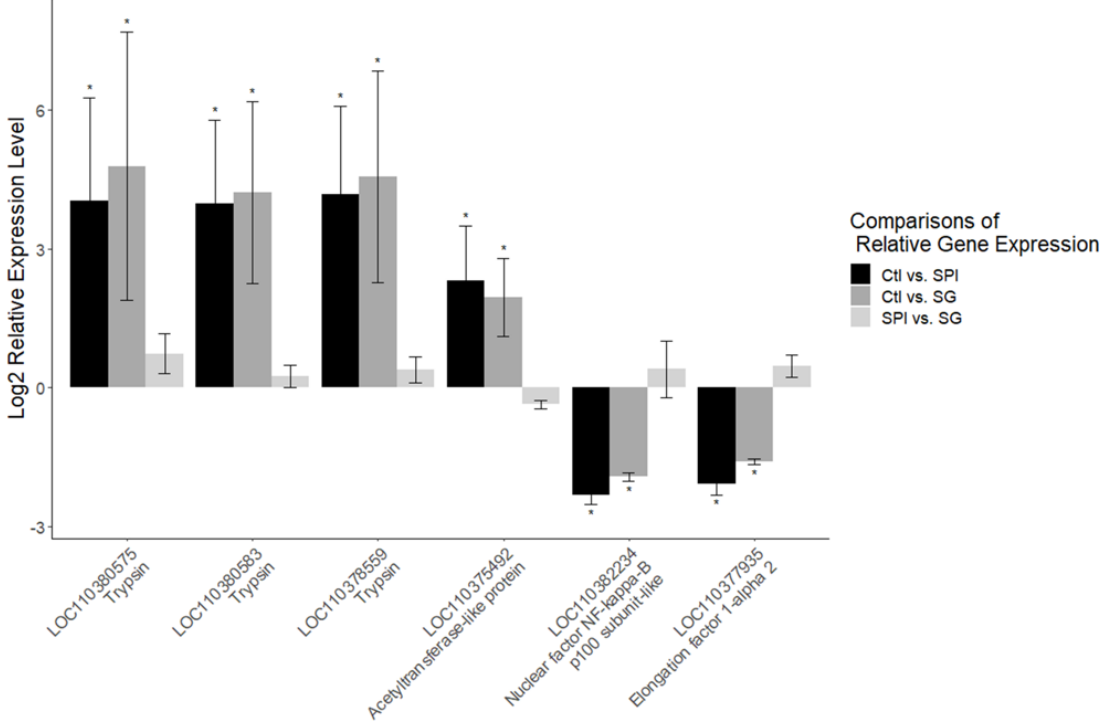
Figure 5. Validation by RT-qPCR of potential epialleles of gene expression patterns induced in H. armigera larvae by SPIs. * Significant differences (Log2 > 1 or < −1 , p < 0.05) for differentially expressed genes . Table 1. Potential epialleles of upregulated genes induced by SPIs in H. armigera larvae. SPI vs. Ctl SG vs. Ctl Locus Change